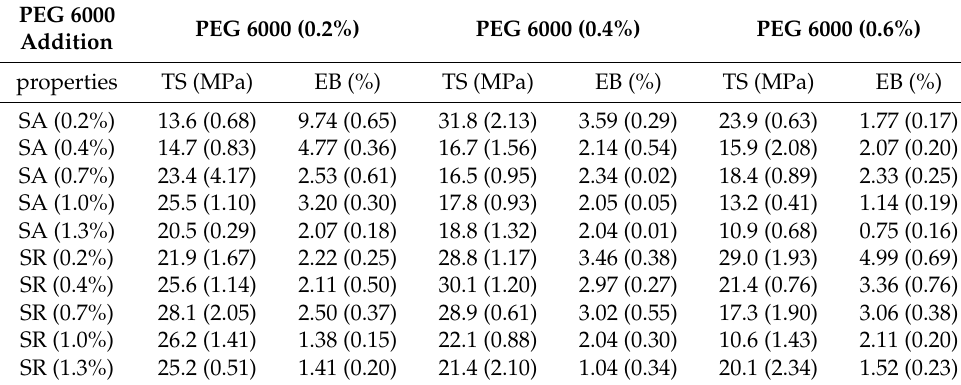
Table 4. The effect of PEG6000 addition on the tensile strength (TS) and elongation at break (EB) of the composite